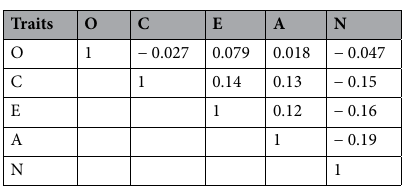
Table 1. The correlation matrix between five personality traits in Essays